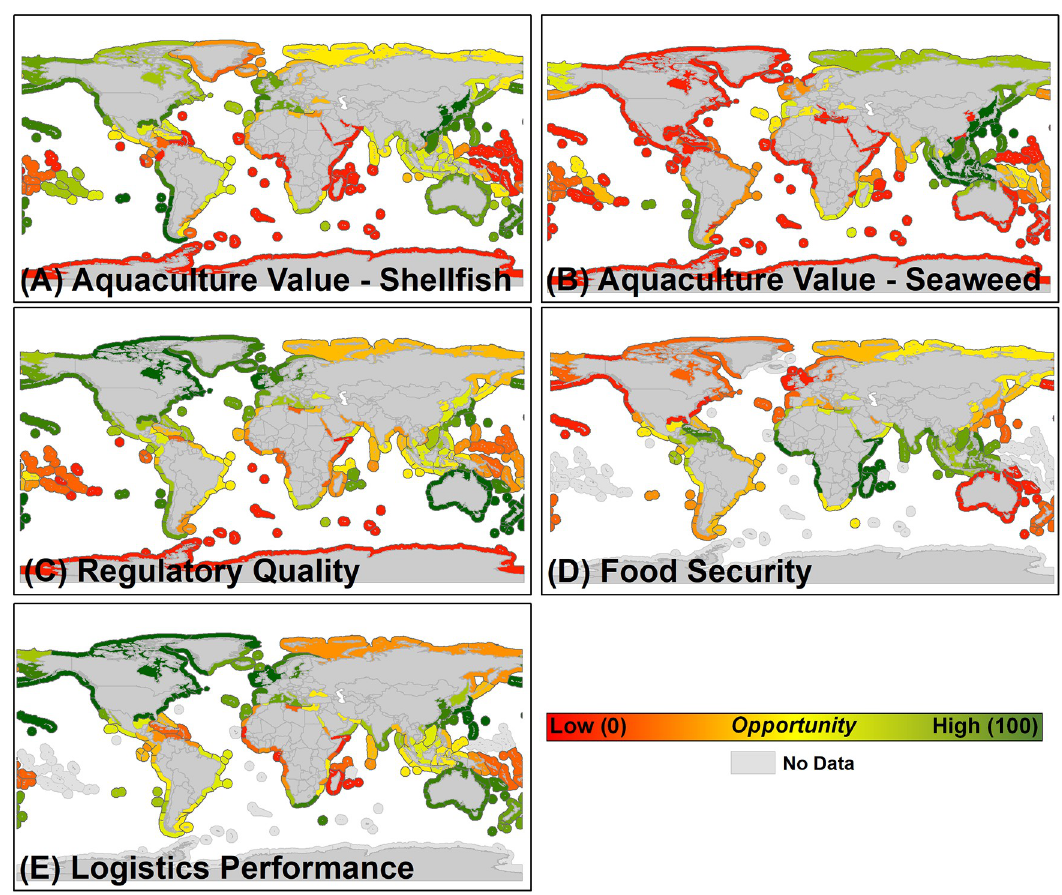
Fig 2. Socioeconomic factors integrated within the restorative aquaculture opportunity index used in determining high opportunity marine ecoregions for shellfish and seaweed restorative aquaculture development, including (A) aquaculture production value for shellfish, (B) aquaculture production value for seaweed, (C) regulatory quality, (D) food security, and (E) logistics performance. All factors are re-scaled to represent where shellfish and seaweed aquaculture development would provide maximum benefits. For example, marine ecoregions with the greatest regulatory quality (C) are re-scaled to represent the highest opportunity ecoregions (dark green) where shellfish and seaweed aquaculture could be adequately governed to ensure sustainable